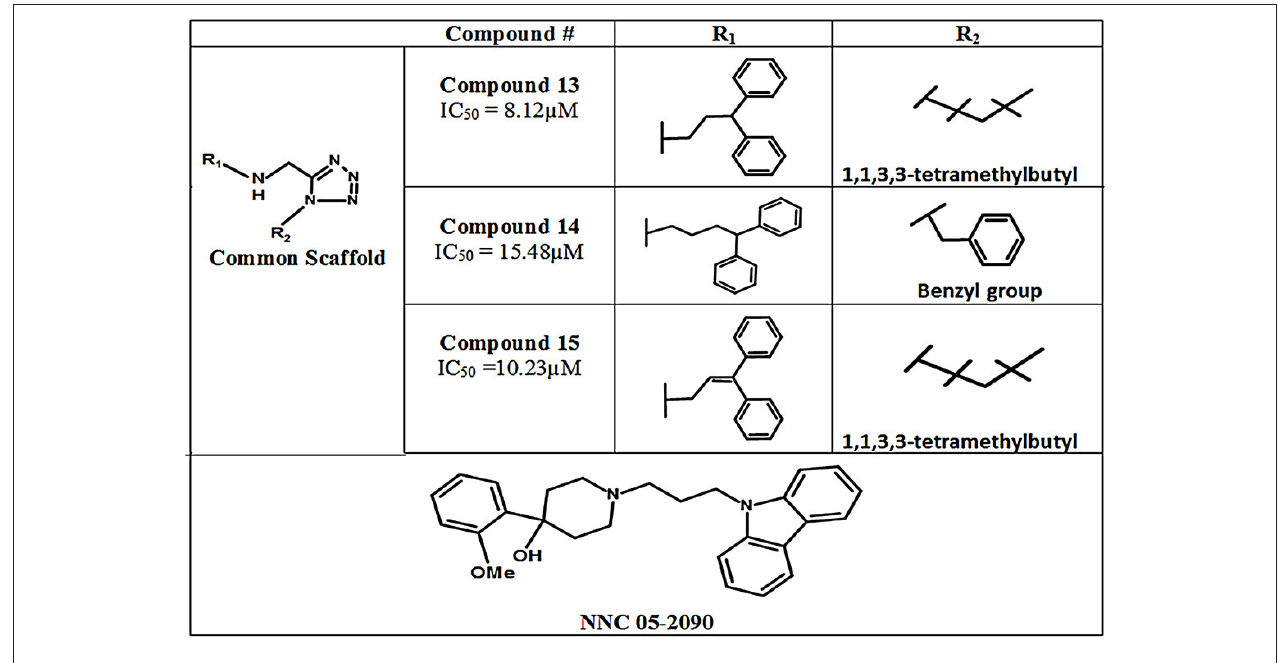
FIGURE 12 | Chemical structures of aminomethyltetrazoles-type modulators of hGAT1.